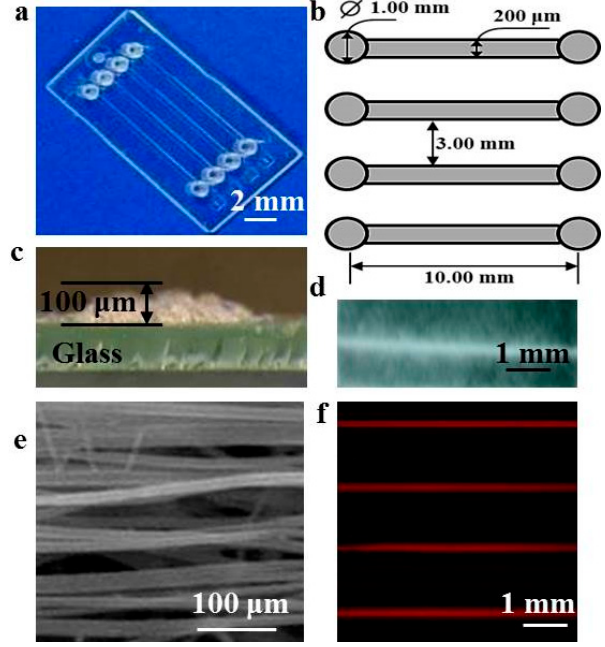
Figure 2. ( a ) Digital image of patterned fiber-embedded microfluidic chip; ( b ) schematic illustration of the perfusion device design; ( c ) optical image of a vertical section of patterned fi bers deposited on the glass; ( d ) digital image of patterned fibers; ( e ) SEM image of patterned fi bers; ( f ) fluorescence image of rhodamine B dye within the microfluidic